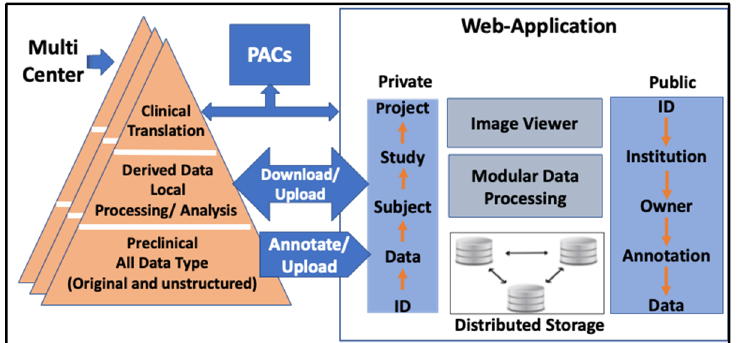
Figure 1. Conceptual design and data model for Biomedical image Registration, Analysis, and Translation (BiRAT). The model illustrates the workflow on how pieces of data elements are curated and added early immediately after its creation to the database system. Robust image viewer facilitates quick image preview and analysis.